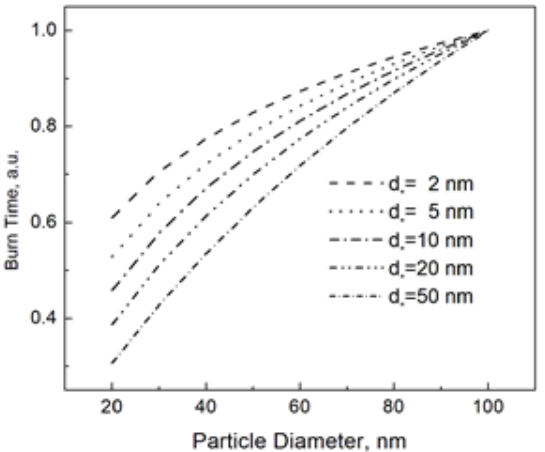
Figure 1. Nanoparticle burn time calculated using Equation (6) at different d * . The burn times at the given d * are normalized to that for the nanoparticle size of 100 nm.